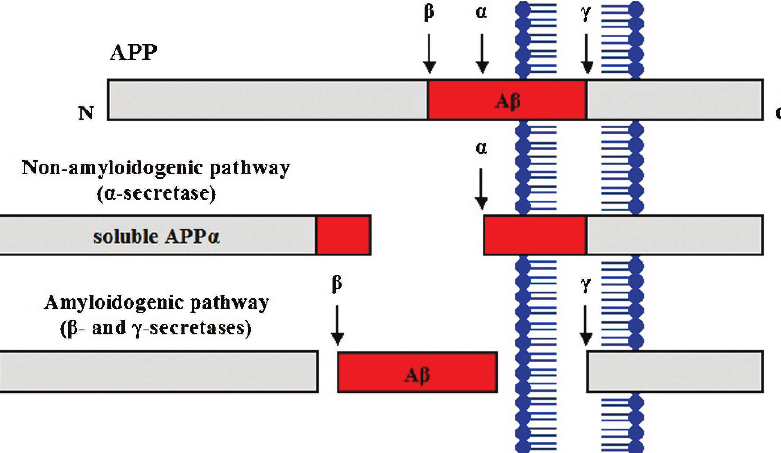
Figure 1 - Schematic diagram illustrating proteolytic cleavage of the amyloid precursor protein (APP). a -Secretase (non-amyloidogenic pathway) cleaves APP within the A b domain to liberate two peptides, including the neuroprotective soluble APP a , whereas b - and c - secretases (amyloidogenic pathway) act sequentially to cleave APP in the N- and C-terminal portions of the A b region, respectively, producing A b peptide and initiating neurodegenerative